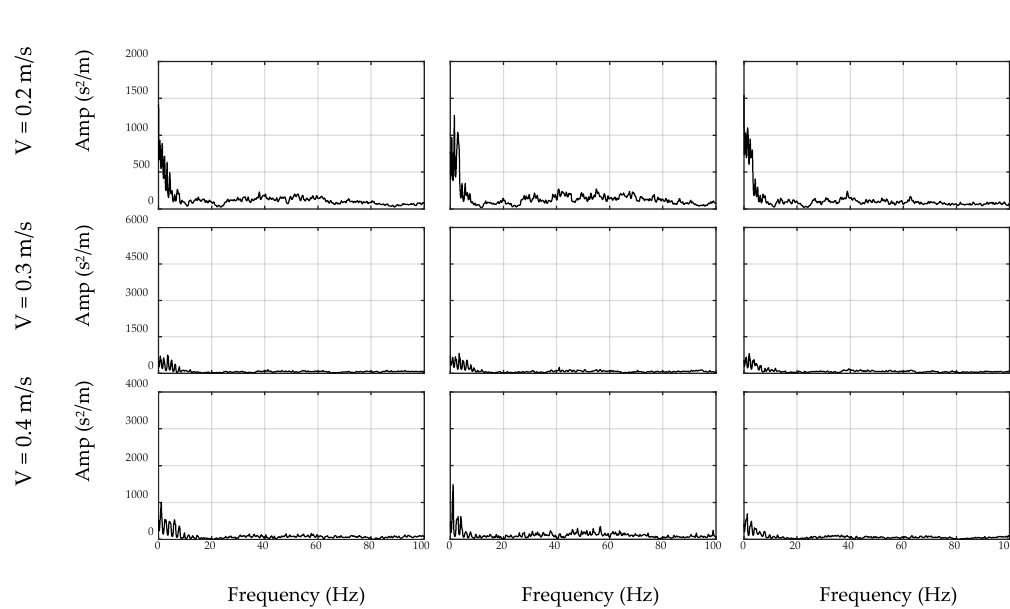
Sensors 2020 , 20 , x FOR PEER REVIEW Figure 15. Inverse filter prototype based on collected signals by smartphone. Figure 15. Inverse filter prototype based on collected signals by smartphone.